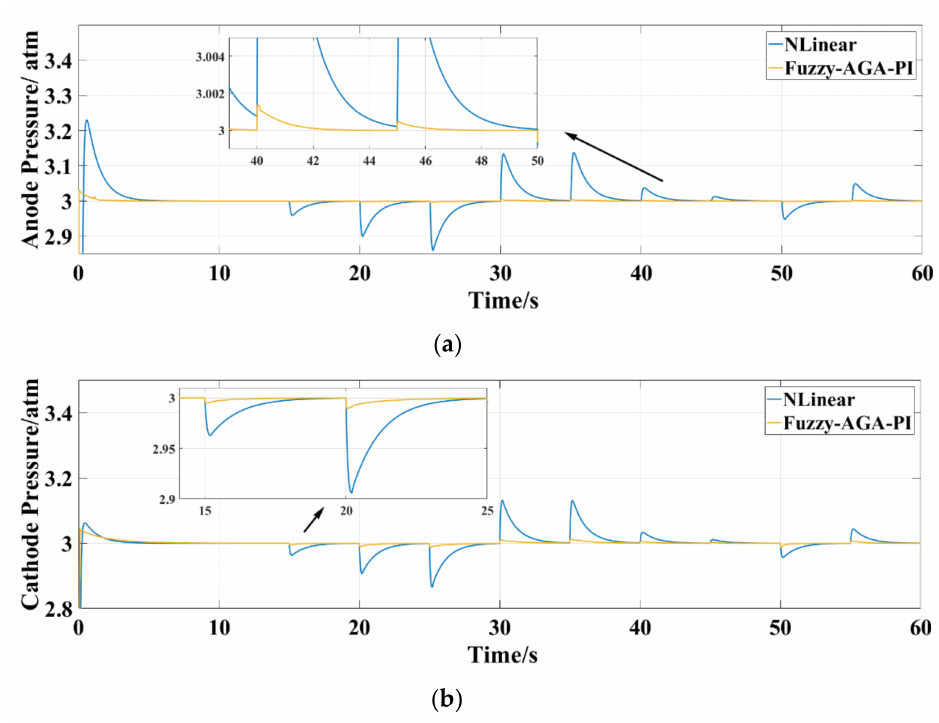
Figure 7. Performance curve of anode and cathode pressures during load variation.